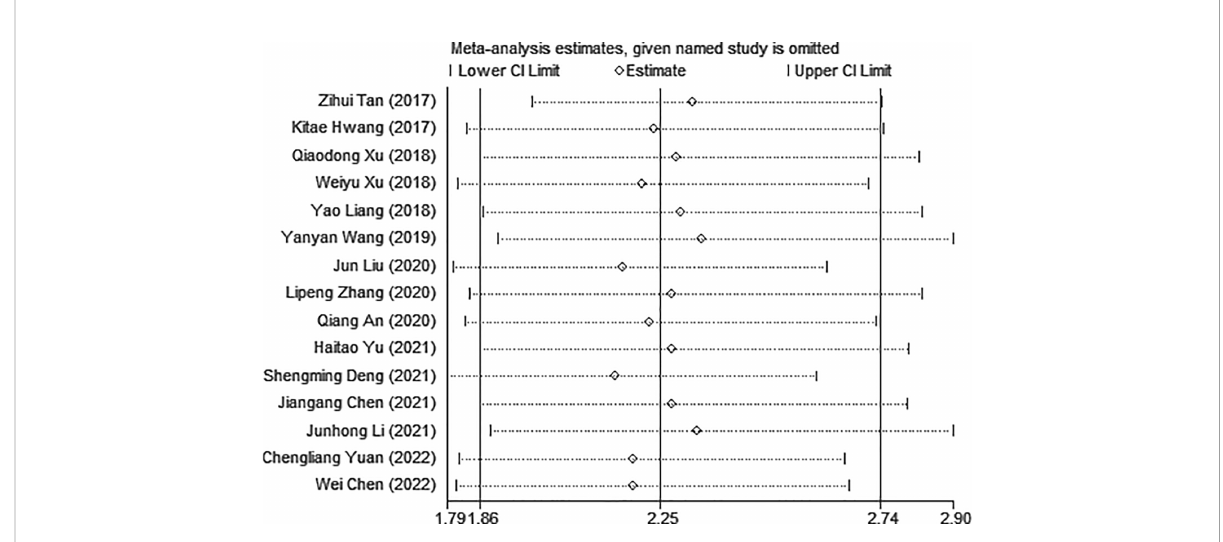
FIGURE 3 Sensitivity analysis for the association between FAR and OS. OS, overall